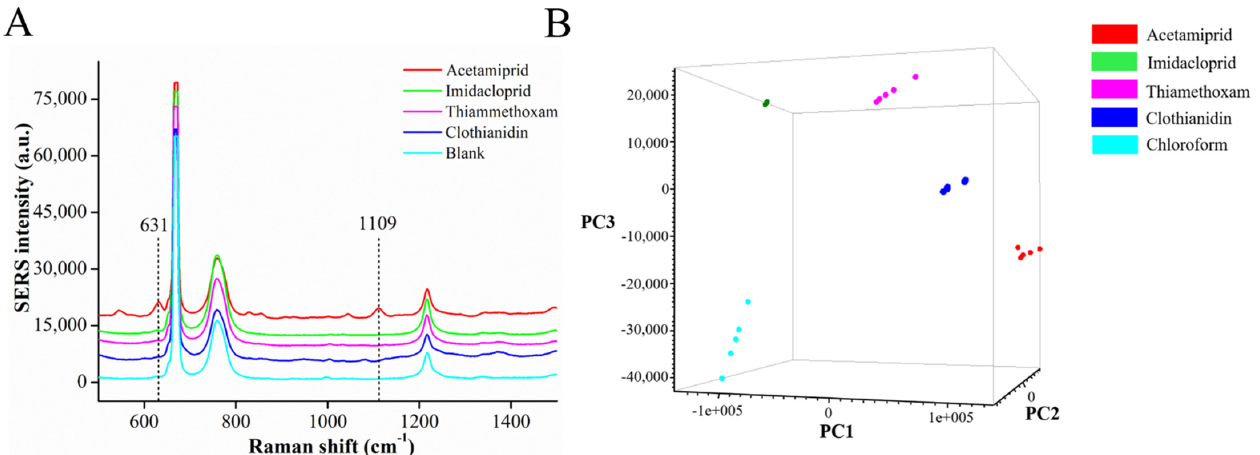
Figure 5. ( A ) SERS spectra of acetamiprid and other neonicotinoid pesticides with a similar structure (imidacloprid, thiamethoxam and clothianidin) at a concentration of 1. 0 × 10 − 5 mol/L; ( B ) PCA plot of SERS spectra of acetamiprid, imidacloprid, thiamethoxam clothianidin, and blank.